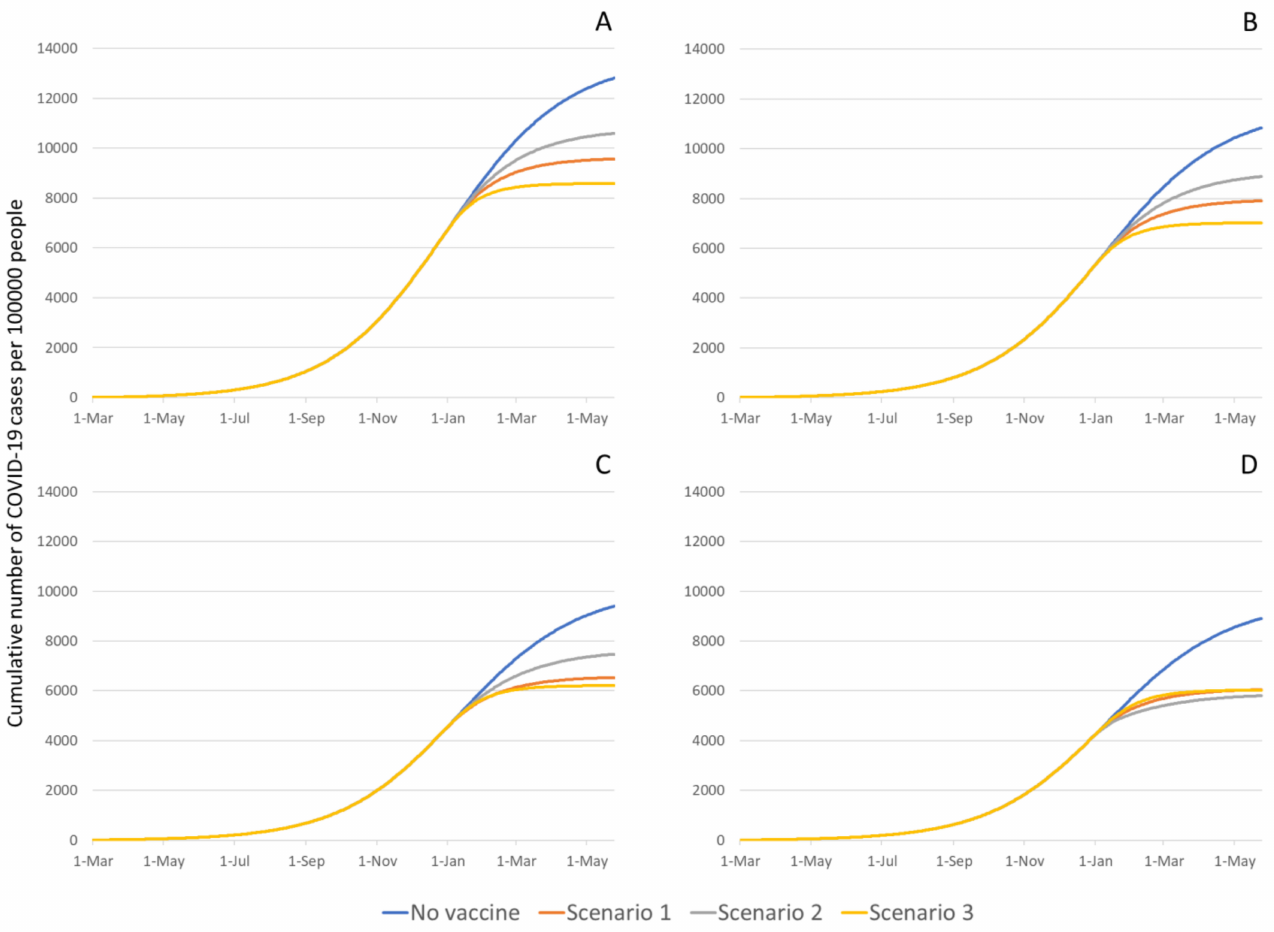
Figure 1. COVID-19 cumulative cases per 100,000 people in each risk area group. ( A ) Group 1-counties with airports with more than 50,000 passengers per year, ( B ) Group 2-counties surrounding the counties with airports, ( C ) Group 3-counties with main highways crossing the county, and ( D ) Group 4-counties with main highways crossing the county. The cumulative number of cases was defined as the number of cases in each risk area divided by the population size in each risk area multiplied by 100,000 people. The no-vaccine prediction was based on best fitted model to data obtained from the Ohio Department of Health